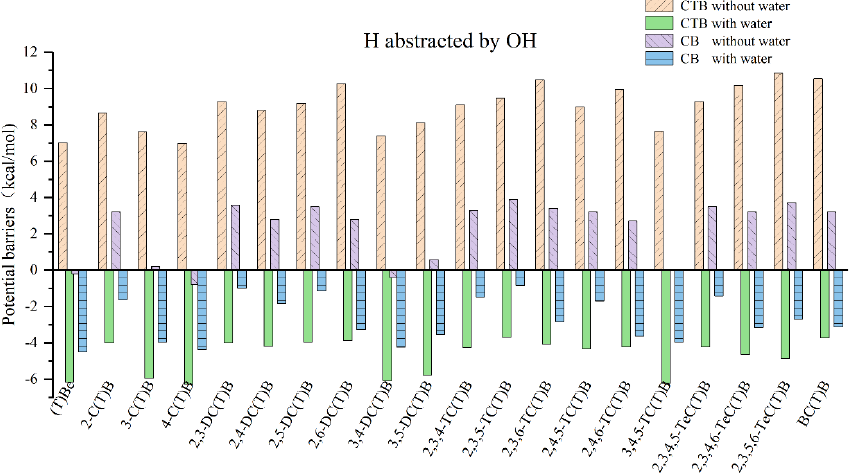
Figure 6. Histograms of potential barriers ∆ E (in kcal mol − 1 , including ZPE correction) of the H abstraction from CTBs and CBs by · OH radical in hydrated and non-hydrated cases. For com- parison, ∆ E of the H abstraction from CBs in hydrated and non-hydrated cases are provided by References [36,39],